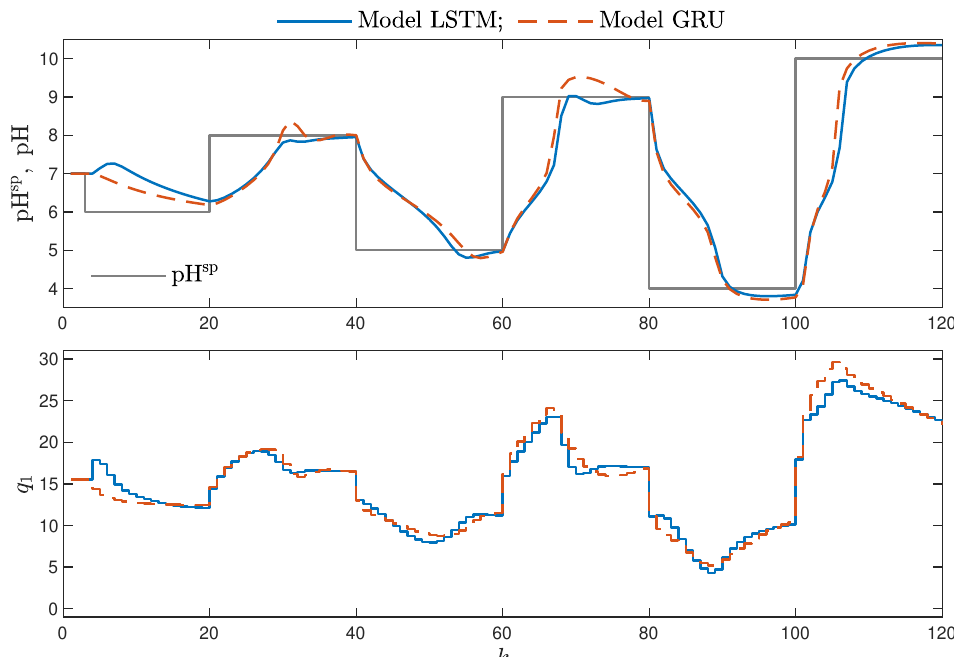
Figure 19. The neutralisation reactor: MPC results with the LSTM and GRU models for n N = 1, n A = n B =